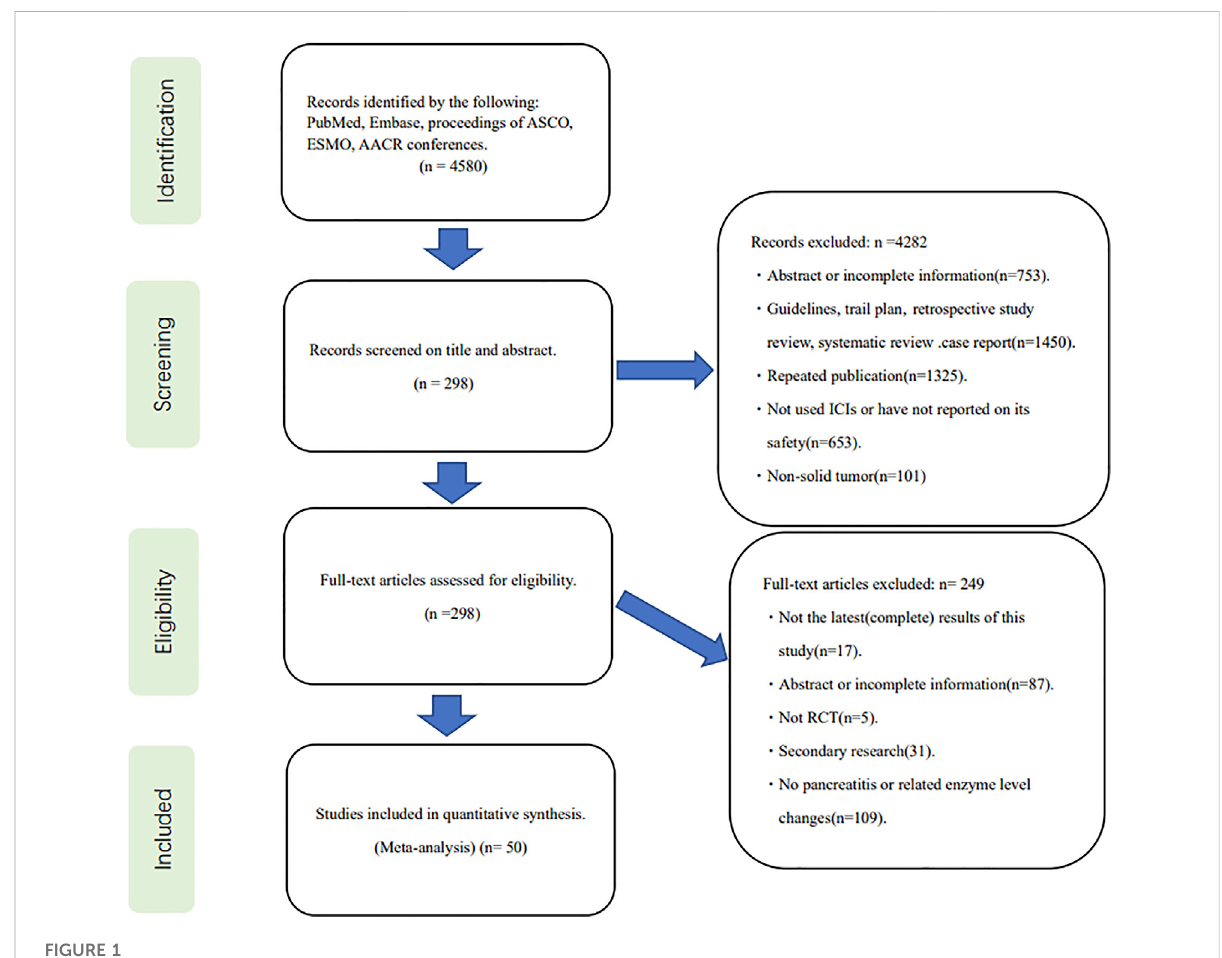
FIGURE 1 Flowchart for study